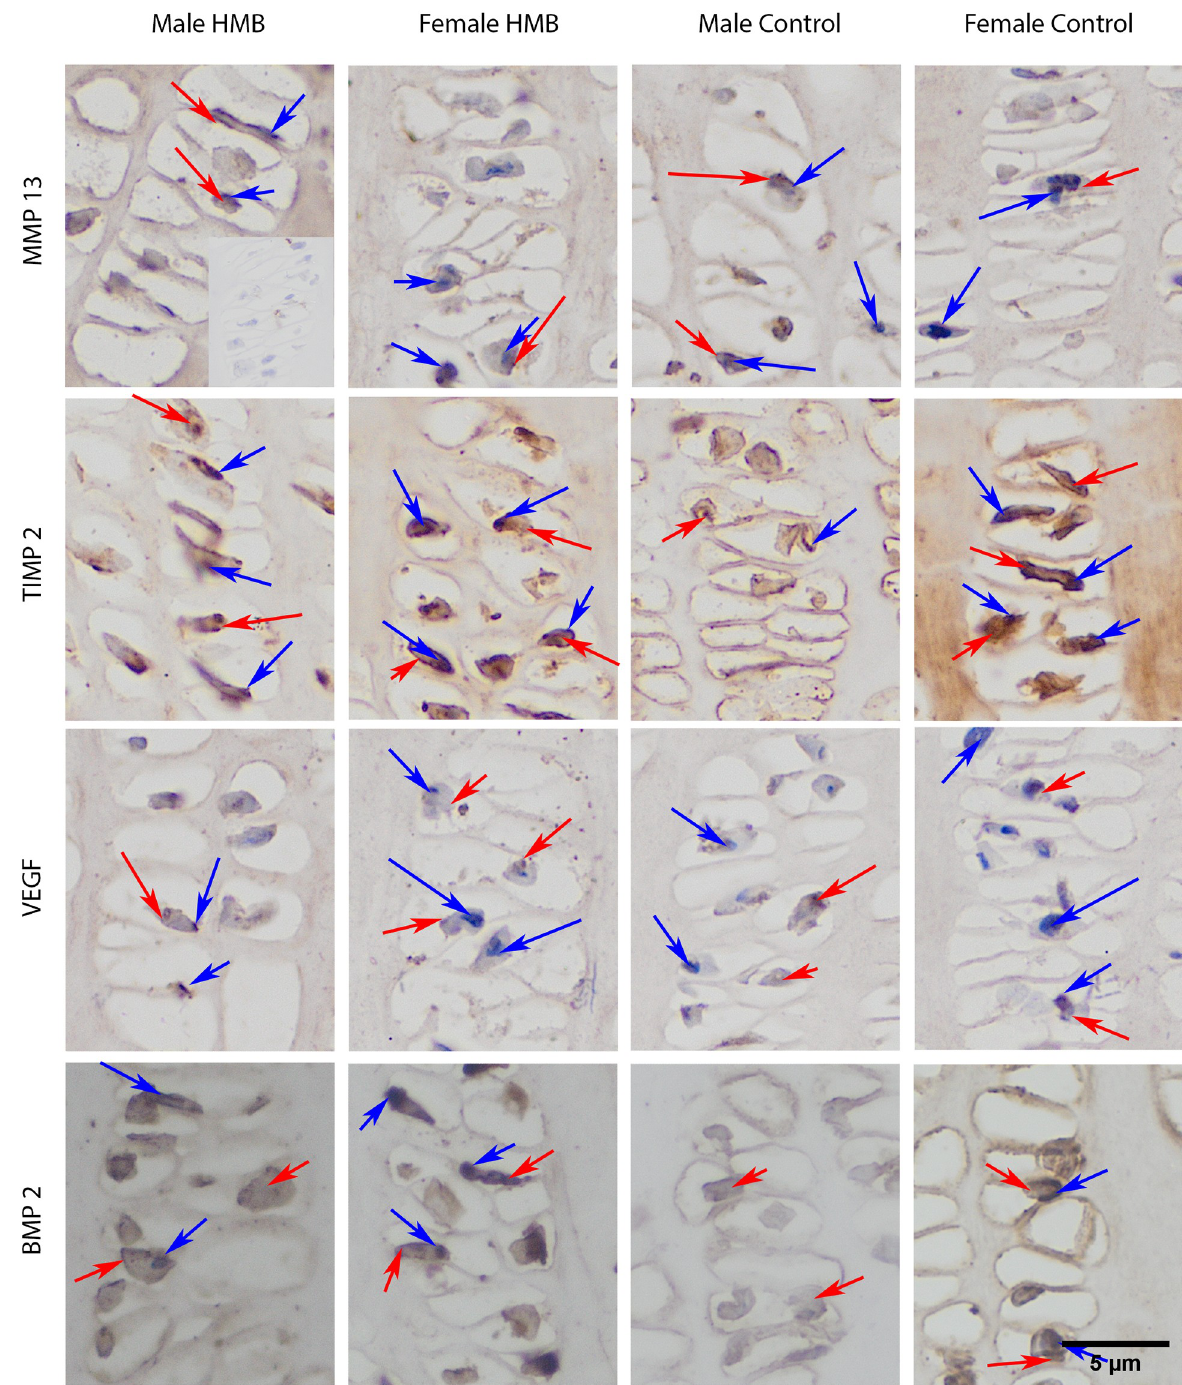
Fig 4. Immunohistochemical analysis of the immunolocalization the MMP13 (matrix metalloproteinase 13), the TIMP2 (tissue inhibitor of metalloproteinases 2), the VEFG (vascular endothelial growth factor) and the BMP2 (bone morphogenetic protein 2) from the proliferative zone of growth plate cartilage. Representative images immunohistochemical analysis carried out on the formaldehyde-fixed from the humerus growth cartilage of newborn piglets. The positive reaction (presence of MMP13, TIMP2, VEFG, BMP2) in the cytoplasm or cell nucleus was marked in red, while the lack of expression was marked in